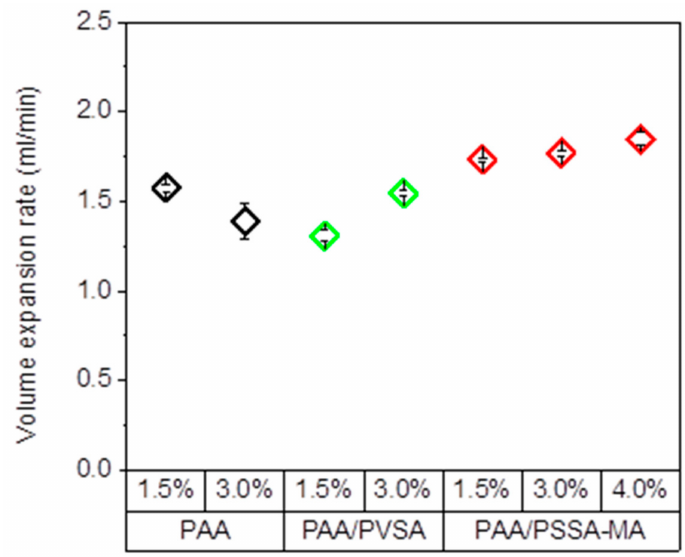
Figure 8. Lifting rate of a 5 kg weight by the different